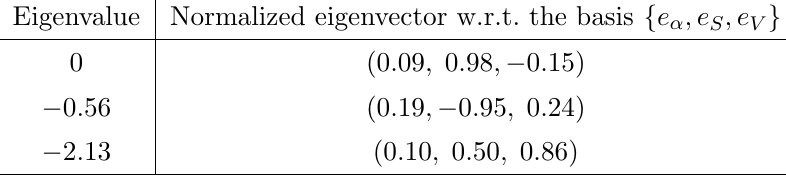
Table 2. Eigenvalues and eigenvectors at the saddle-node bifurcation at x = 4 :